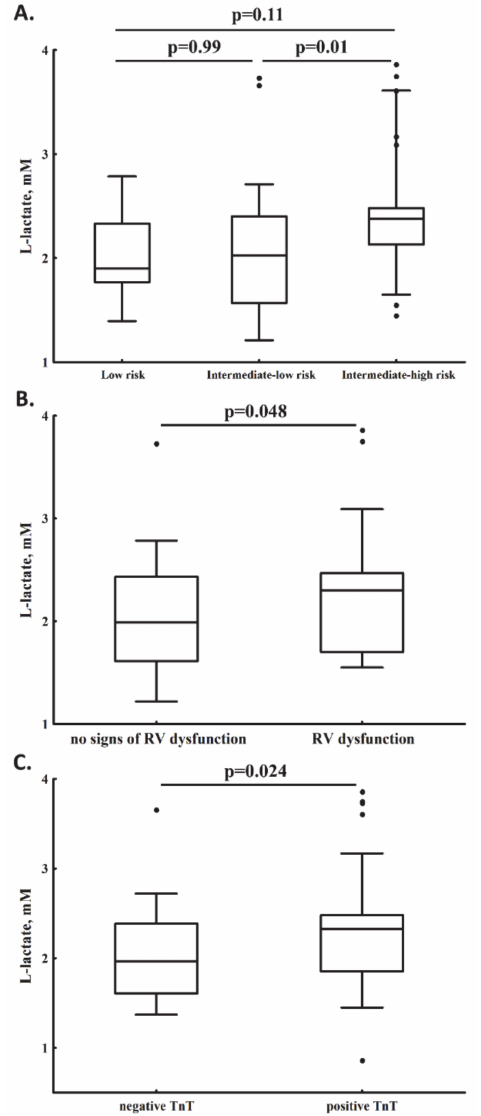
Figure 1. Plasma lactate levels determined in acute pulmonary embolism patients with low, intermediate–low, and intermediate–high early mortality risk (panel A , p < 0.05 for ANOVA) as well as in subjects with or without right ventricular (RV) dysfunction (panel B ), and in those with positive or negative troponin T (TnT; panel C ). Patients with plasma lactate levels ≥ 2 mM were characterized by 36.9% higher white blood cell (WBC) and 29% higher neutrophil counts along with 44.7% elevated citH3 levels (Table 1). Lactate concentrations were associated with WBC count (r = 0.18, p = 0.043), but not neutrophil